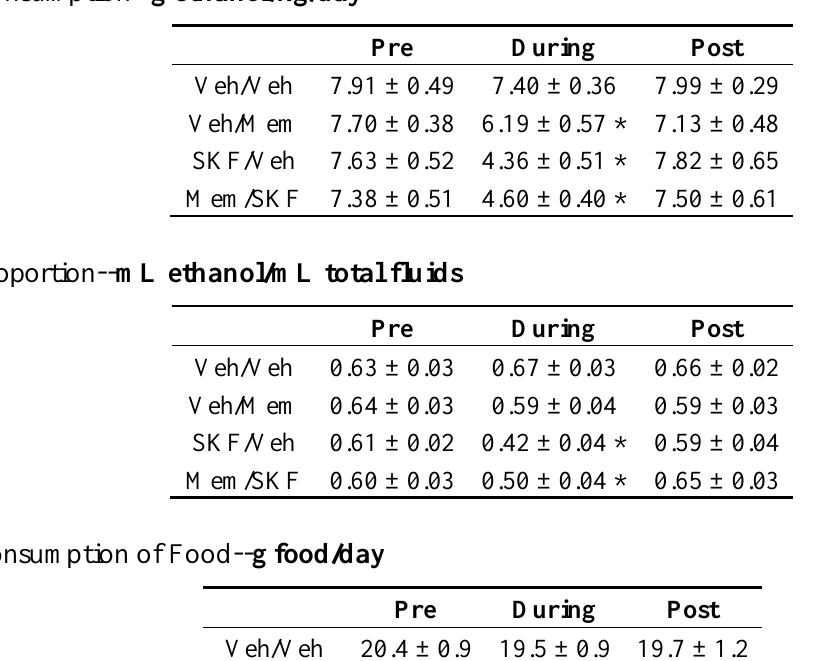
Table 2. Effects of 5.0 mg/kg SKF-38393, 3.0 mg/kg memantine, or in combination b.i.d. for three days on daily ethanol consumption, proportion of fluids consumed and food